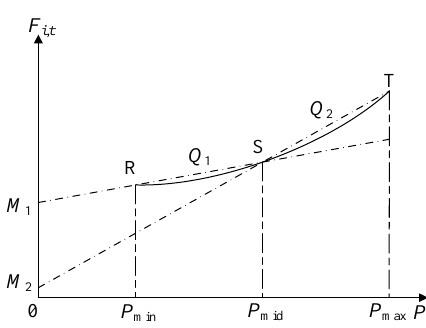
Figure 1. Piece-wise linearization of generation cost function.